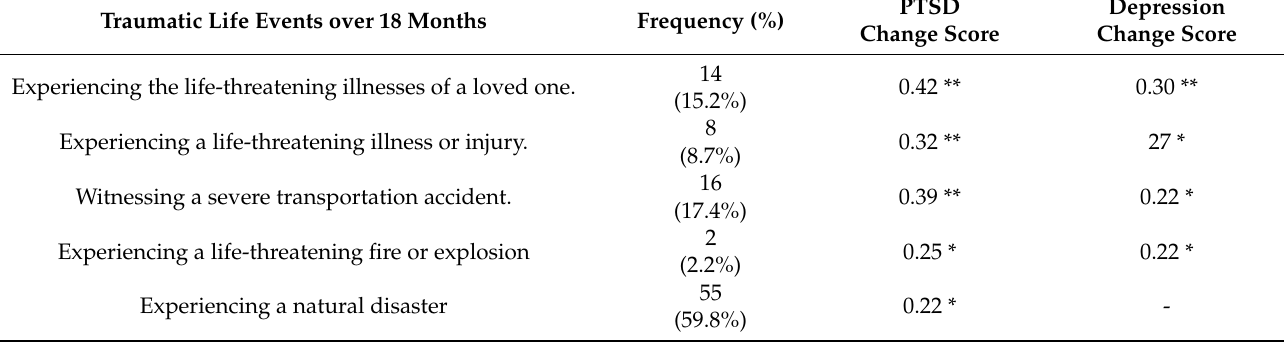
Table 4. Correlation of significant non-war traumatic events with PTSD and depression change